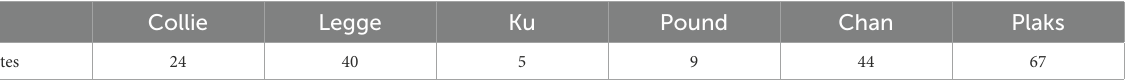
TABLE 11 Comparison of the number of notes of the six